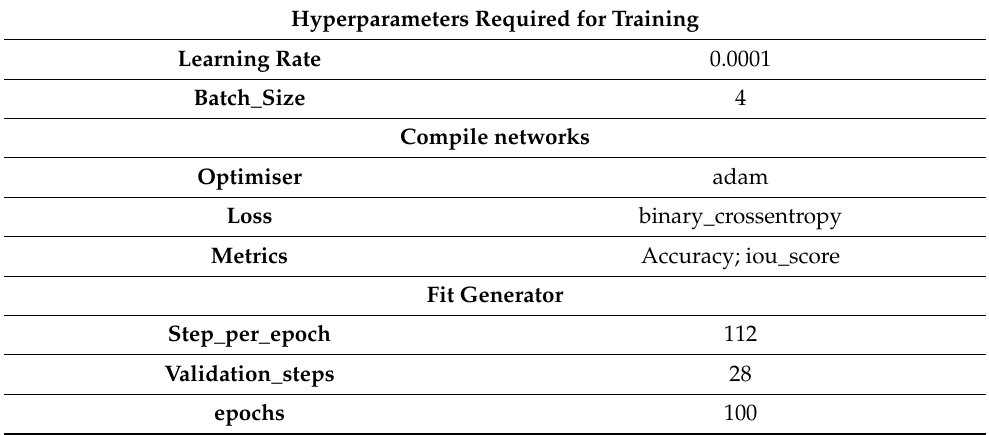
Table 2. Hyperparameters required for the training phase for both CNN